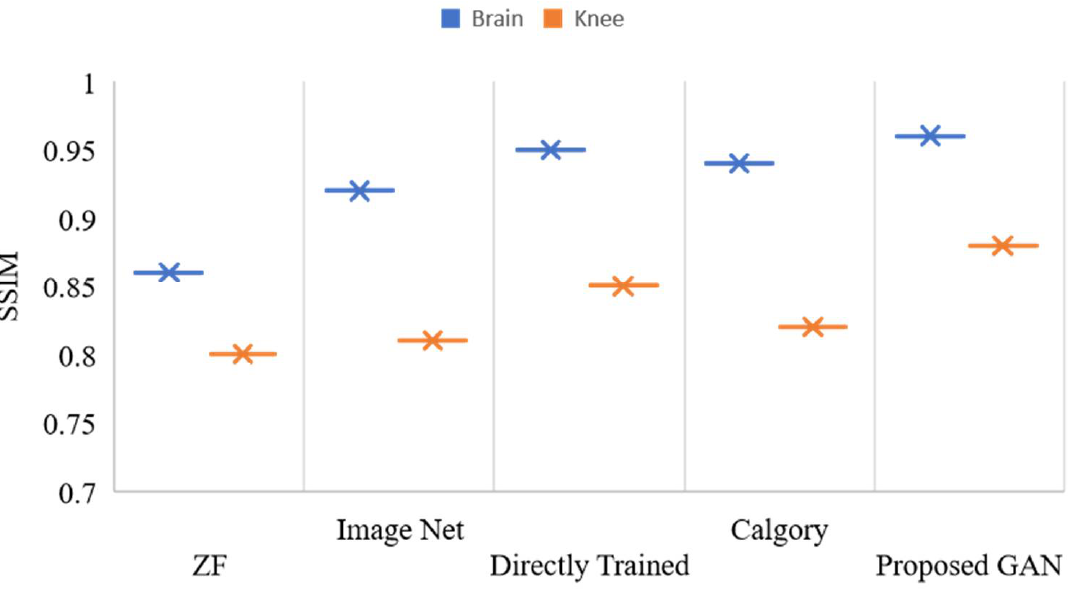
Figure 12. SSIM, values of reconstructed images of the knee and brain using various models, with AF = 2.